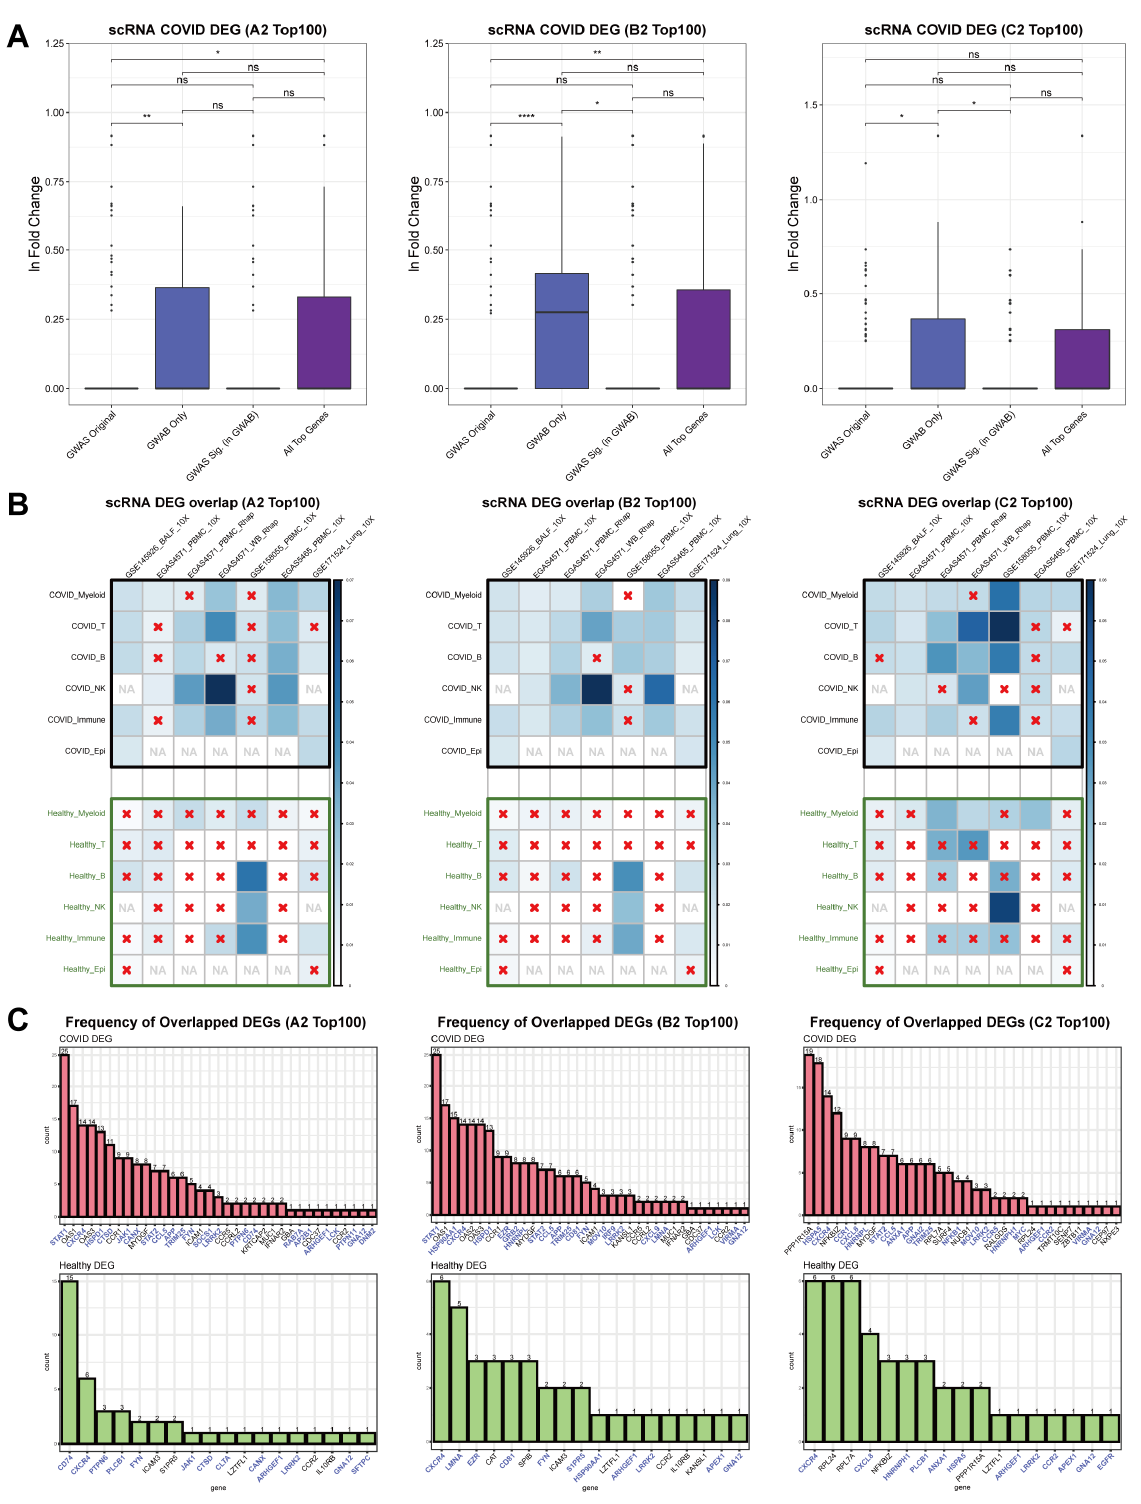
Figure 3. Overlaps of differentially expressed genes (DEGs) between COVID patients and healthy controls for each cell type from single-cell RNA-seq datasets. ( A ) Comparison of fold changes of GWAB top 100 genes for each gene group. The Wilcoxon signed-rank test is used for the p values. Statistical significance : ns ( p > 0.05), * ( p ≤ 0.05) , ** ( p ≤ 0.01), *** ( p ≤ 0.001), **** ( p ≤ 0.0001). ( B ) Overlaps between DEGs and GWAB top 100 genes. The color scale indicates the overlap percentage, a red × indicates no significant overlap for the corresponding categories ( p > 0.05, Fisher’s exact test), and NA indicates no available DEGs for the corresponding categories. ( C ) Overlap counts for COVID DEGs and control DEGs. The genes in blue are the ‘GWAB Only’ genes.